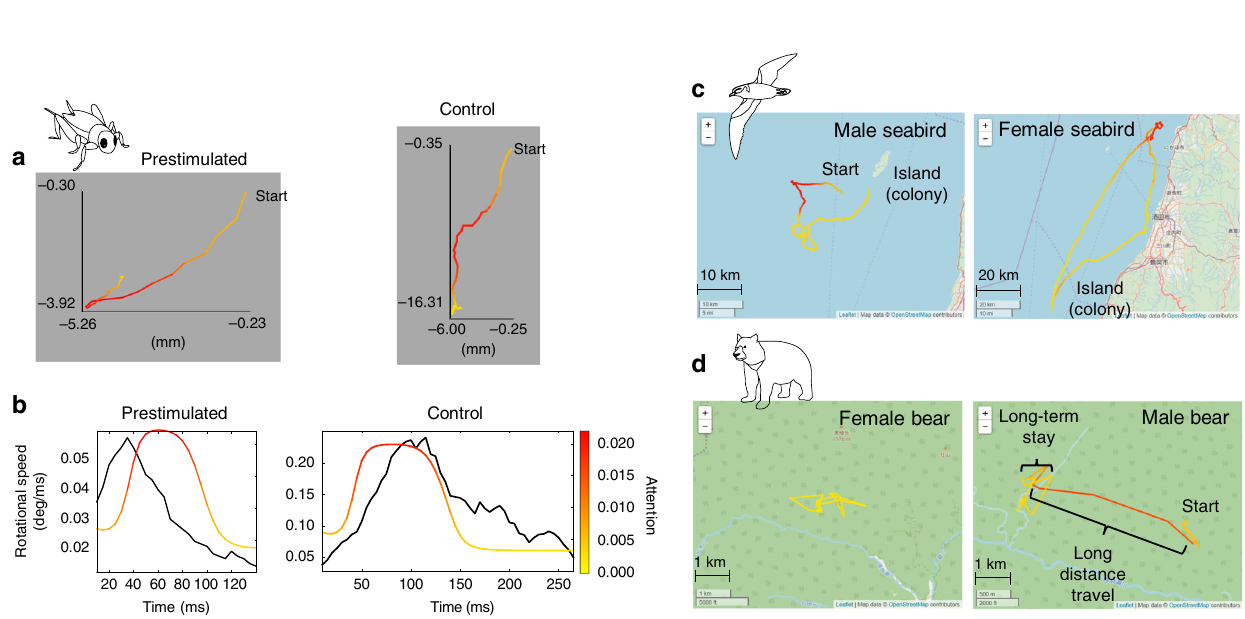
Fig. 6 Highlighted trajectories of crickets, seabirds, and bears. a Trajectories of the prestimulated and control crickets highlighted by DeepHL (see Supplementary Information, Application to the study of crickets, for more detail). b Time series of rotational speed (black lines) and attention value (colored lines) of the trajectories in a . A discriminator layer pays attention to the difference in the peaks of the rotational speed for the prestimulated and control classes. The high rotational speed was sustained in the control trajectory, which means that the crickets exhibited longer and larger turning movements in the control group. In contrast, the rotational speed transiently elevated and peaked earlier in the prestimulated group. c Trajectories of female and male seabirds highlighted by DeepHL. A discriminator layer pays attention to female trajectories when the locations of the female birds are close to the coastline (see Supplementary Information, Application to the study of seabirds). d Trajectories of female and male bears highlighted by DeepHL. The red segment is characteristic of the male bears, as detected by DeepHL. A discriminator layer pays attention to male trajectories when a male bear has traveled a long distance after/before staying in one place (see Supplementary Information, Application to the study of bears). Base map and